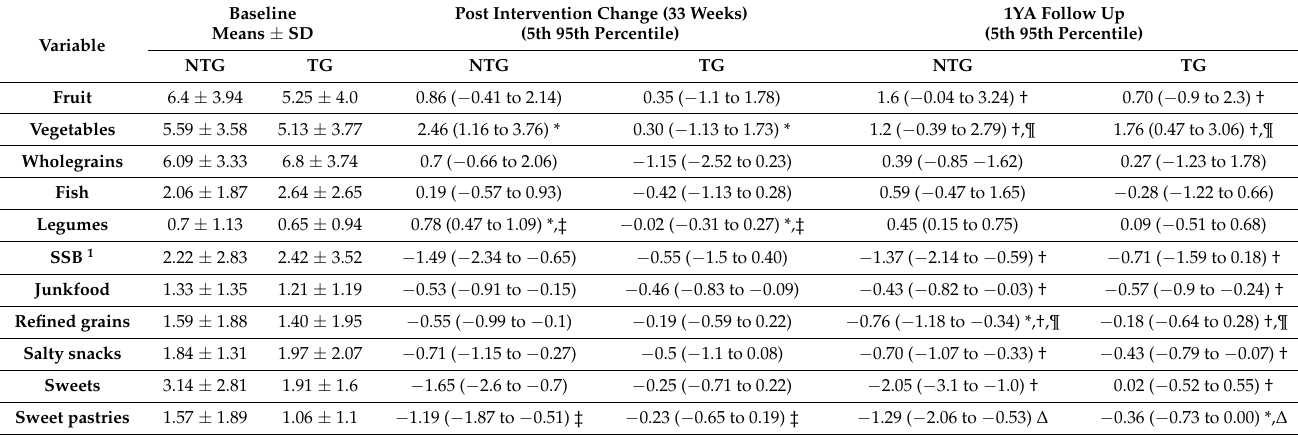
Table 1. Baseline characteristics and average changes in frequency of consumption, expressed as servings per week.